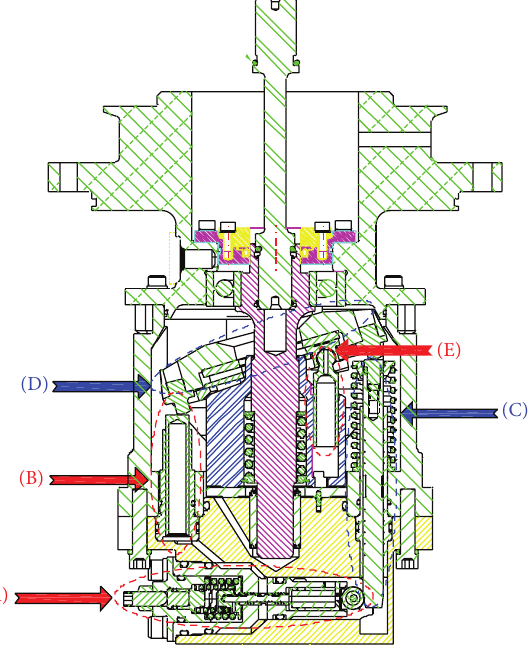
Figure 1: Sectional view of the VDAPP with the mechanical